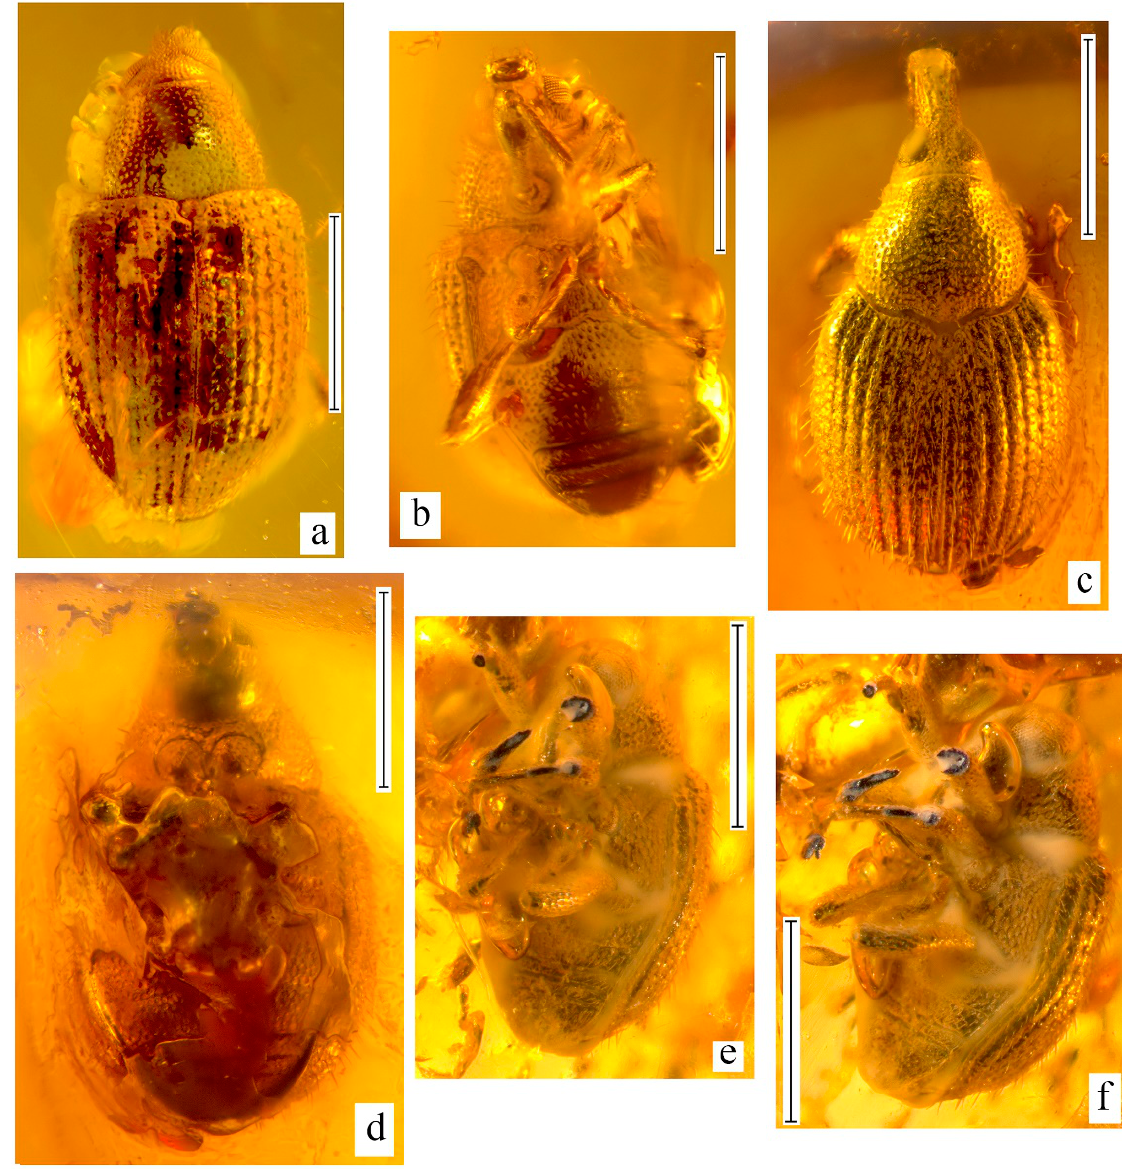
Figure 9. Habitus of Palaeorhamphus spp. from Baltic amber. ( a , b ) P. eichmanni sp. nov. , holotype, FEH , no. 652: body, dorsally ( a ); body, ventrally ( b ). ( c , d ) P. damzeni sp. nov. , holotype, ISEA , no. BA2019 / 4: body, dorsally ( c ); body, ventrally ( d ). ( e , f ) P. primitivus , holotype, ISEA , no. BA2012 / 12: body, ventrally ( e ); body, ventro-laterally ( f ). Scale bars: 1.0 mm. See Section 2 for names of collections.